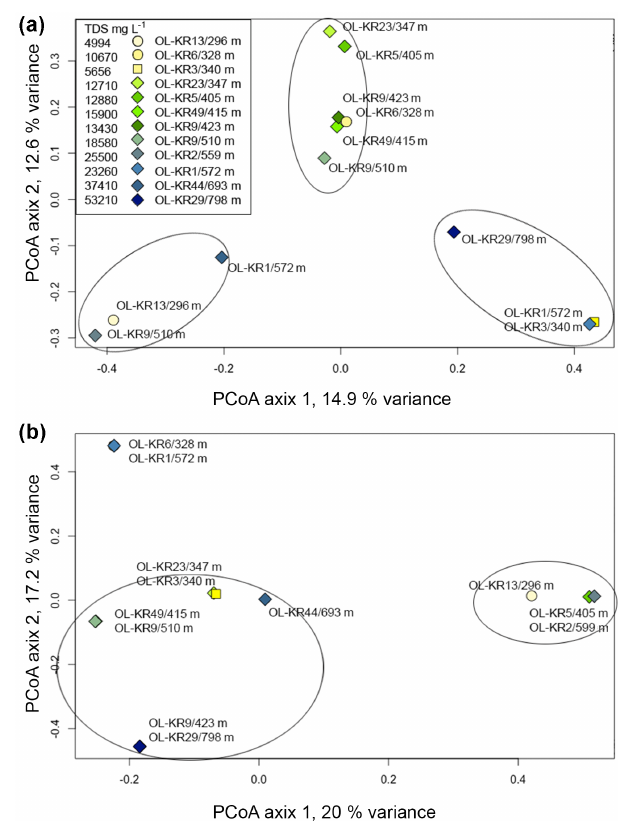
Figure 6. Principal coordinate analysis (PCoA) on all the OTU pro- files of the different samples based on the Bray–Curtis distance model for the (a) archaeal and (b) bacterial communities. The points indicate water type, where the circle is for brackish sulfate-rich wa- ter, the square is for brackish chloride-rich water, and the diamond is for saline water. The colouring of the points is according to the concentration of total dissolved solids (TDS) as indicated in the up- per left corner of (a)